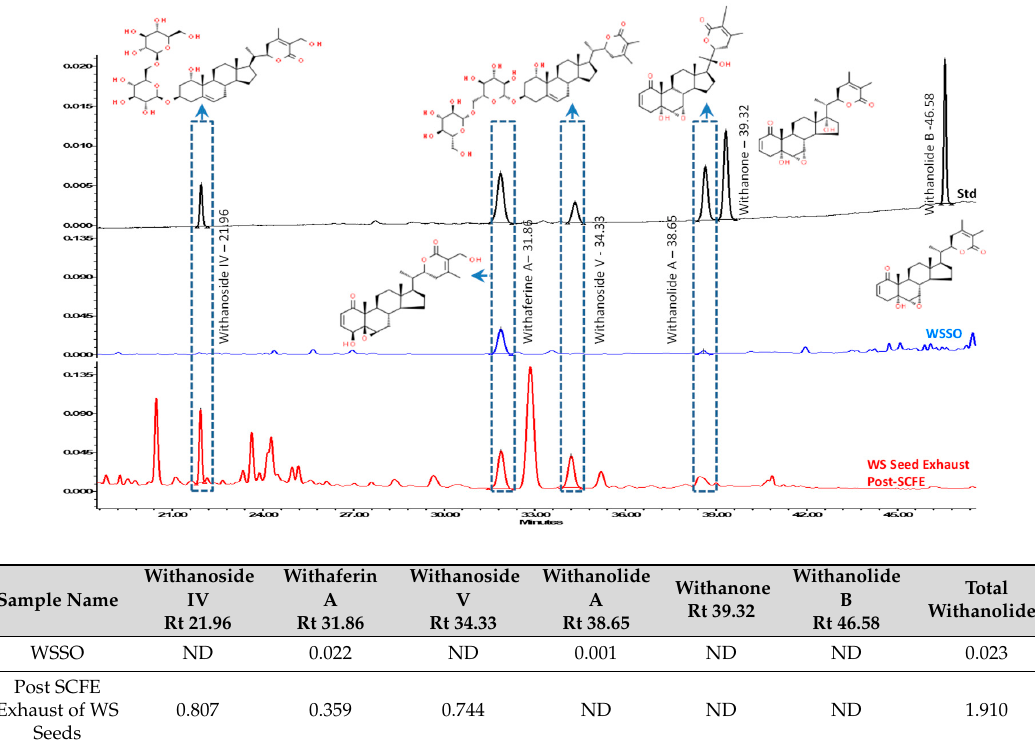
Figure 3. Stacked-up HPLC profiles of WSSO and the post-supercritical fluid extraction (SCFE) exhaust of WS seeds, with known standards: Withanolides contents were identified using standards mix (black line). Post-SCFE exhaust of Withania somnifera Dunal (WS) seeds (red line) showed good presence of withanoside IV, withaferine A, withanoside V, and withanolide A, at standard retention times (Rt). WSSO (blue line) chromatogram show identifiable peaks of withferine A (at Rt, 31.86 min) and of withanolide A (at Rt, 38.65 min). Most of the withanolides tested were identified in WS seed exhaust only. However, withanolide B and withanone were not decteced (ND) in any of the test samples. Relevent structures of withanolides are displayed at their identfied peak, as per standard mix. The observed concentrations of withanolides have been listed as % w / w with their respective retention time (Rt) in both test samples.